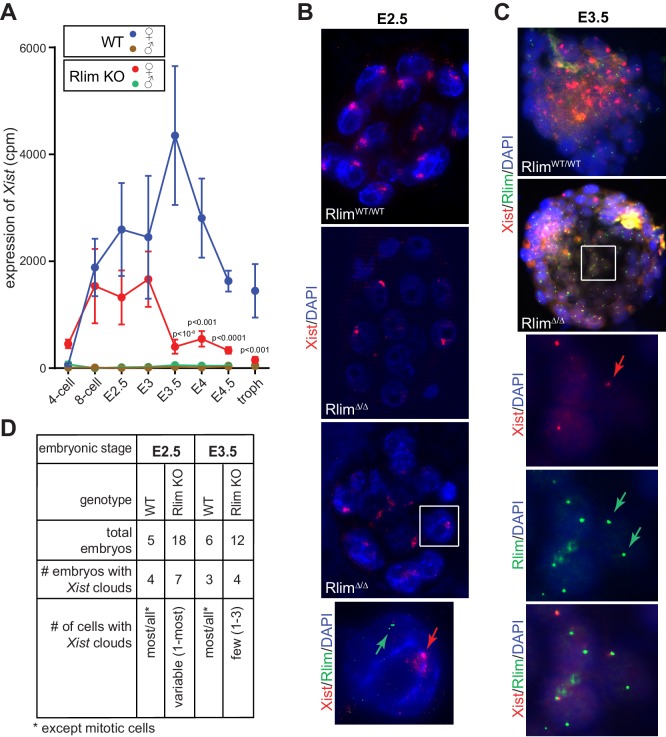
Rlim is required for the maintenance of Xist expression and Xist clouds at blastocyst stages.(A) Expression profiles from the Xist locus in preimplantation embryos WT and KO for Rlim. Error bars indicate standard error of the mean (SEM). Significant differences of Xist levels in WT and KO females P<0.01 are indicated (Student’s t-test). (B) WT and RlimKO embryos at E2.5 were co-stained with probes recognizing Xist (red) and Rlim (green) via RNA FISH. Two representative RlimΔ/Δ embryos are shown. The boxed area is magnified in the panel below. Arrows point at Xist cloud and Rlim transcription focus. (C) RNA FISH on WT and RlimKO embryos at E3.5. The boxed area is magnified in the panels below. Arrows point at Xist and Rlim transcription foci. (D) Tabular summary of Xist clouds detected in B and C.